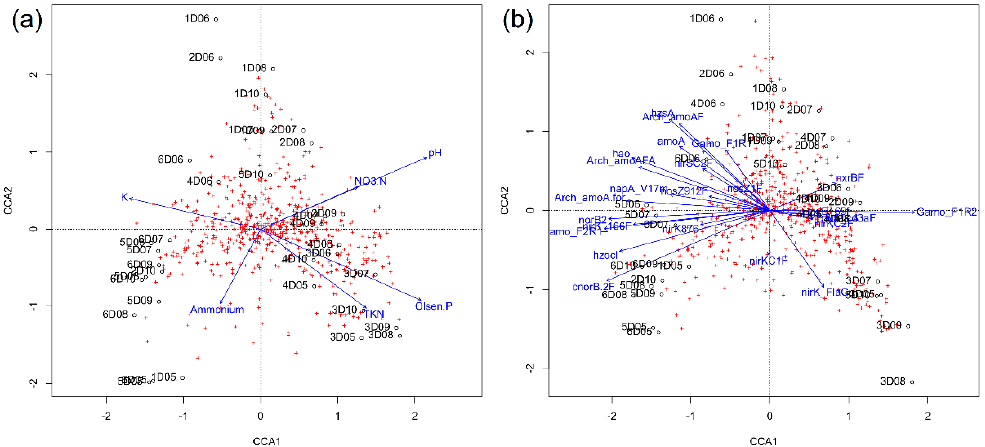
Figure 8. Bacterial beta–diversity and N cycle genes. ( a ) CCA showing relationship between OTU (red crosses) and soil chemical properties (blue lines). ( b ) CCA showing relationship between OTU (red crosses) and transcript copies of N cycle genes (blue lines).